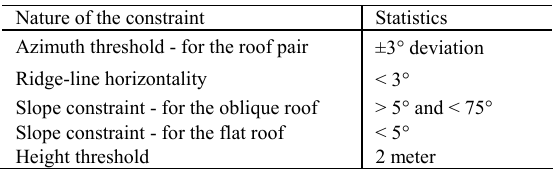
Table 1: Parameters for rules on roof segment extraction